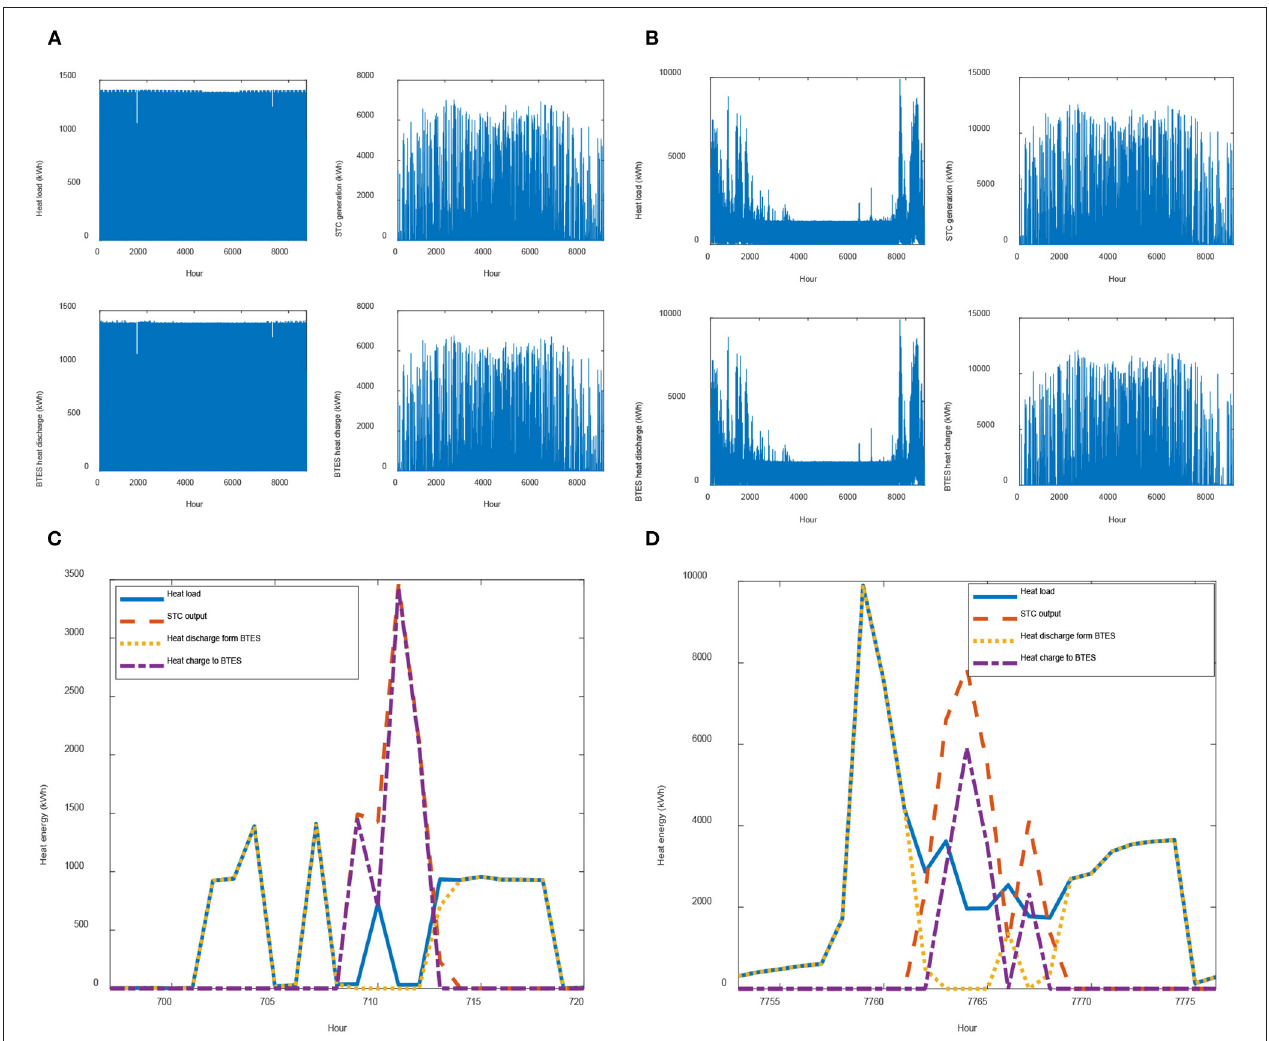
FIGURE 4 | Hourly heat load, STC generation, heat discharged from BTES and charged to BTES for (A) SC2 and (B) SC3; for peak heat load days (PHLDs) in (C) SC2 and (D)